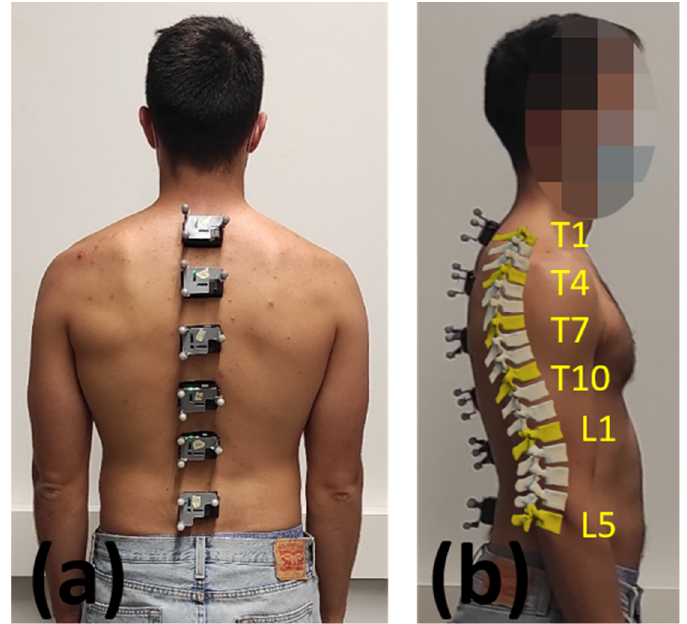
Figure 2. ( a ) Sensors attached to the subject’s body (back view); ( b ) Sensors attached to the subject’s body (lateral view).